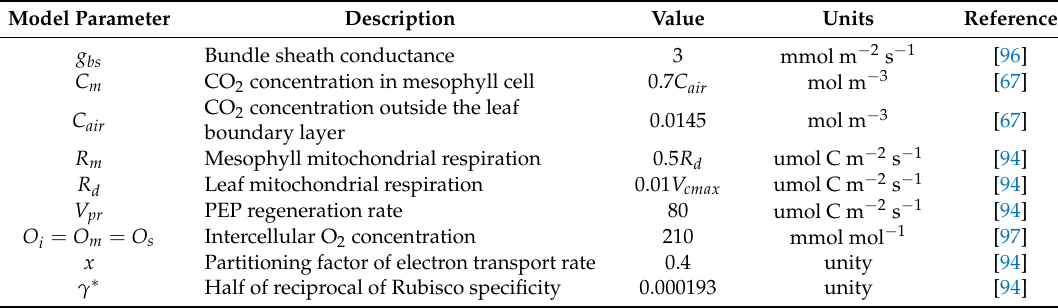
Table A2. C 4 Photosynthesis Model Parameters in